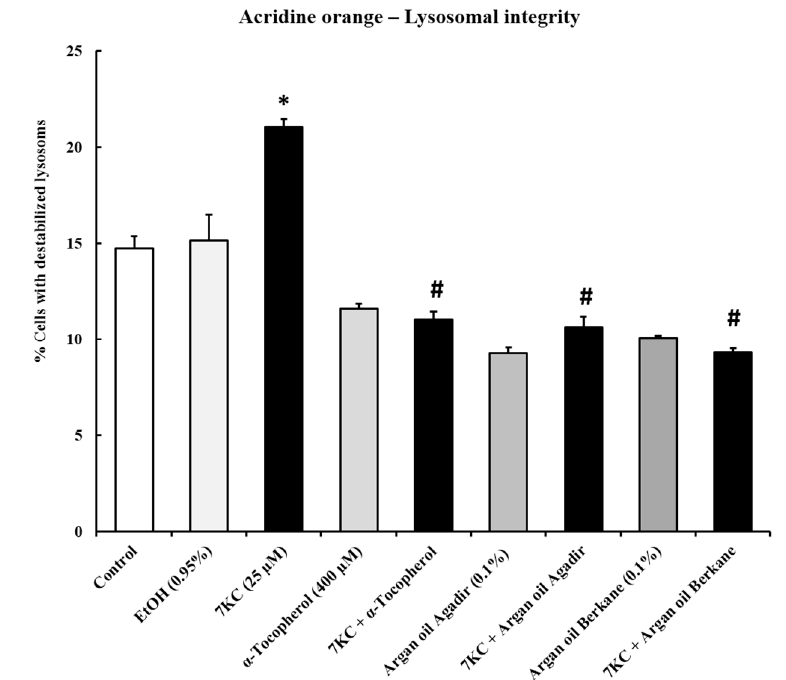
Figure 4. Evaluation of the effect of argan oil on 7-ketocholesterol-induced acidic vesicle formation in 158N murine oligodendrocytes by flow cytometry after staining with acridine orange. After 24 h of culture, 158N murine oligodendrocytes were cultured for an additional 24 h without or with